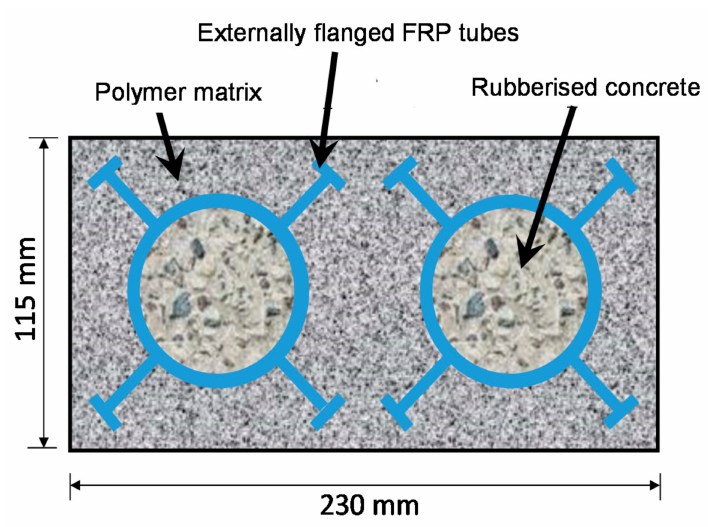
Figure 1. Cross-sectional view of the proposed composite railway